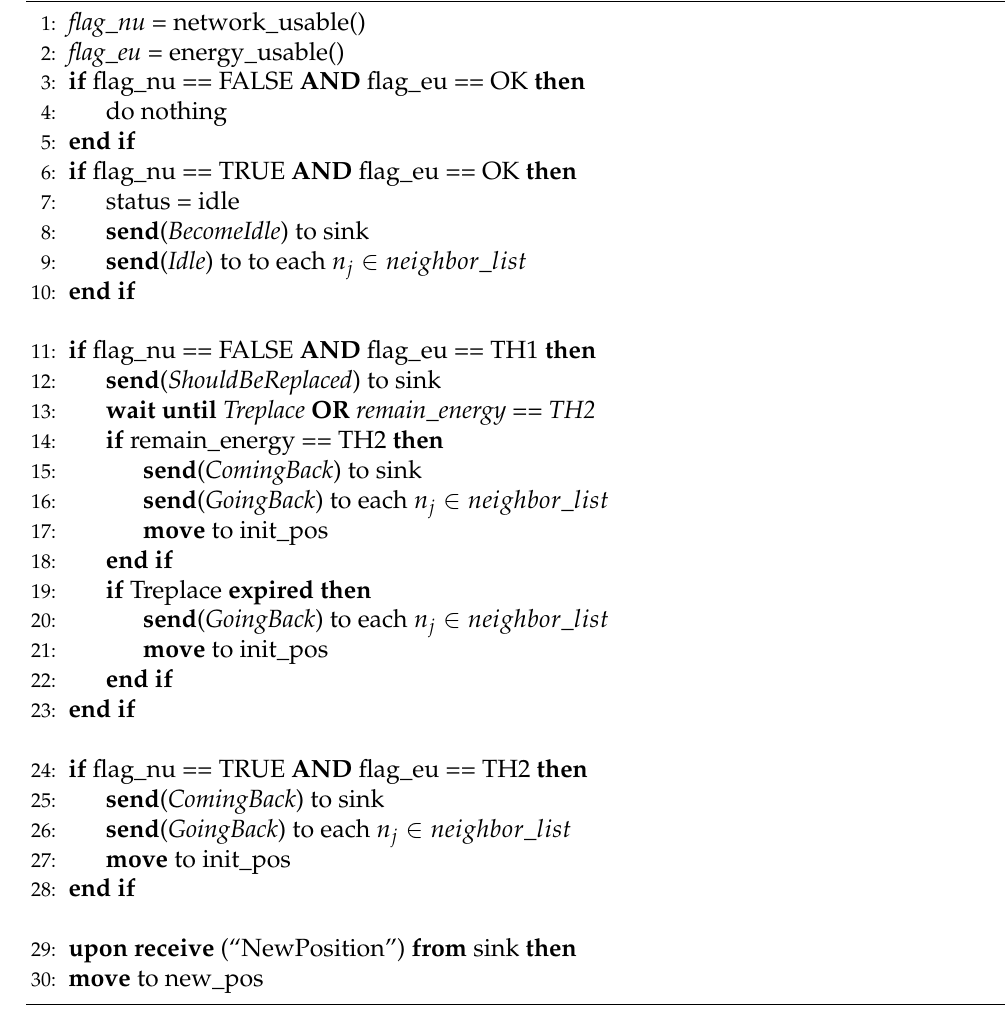
Algorithm 5 Periodic check algorithm for mobile node m